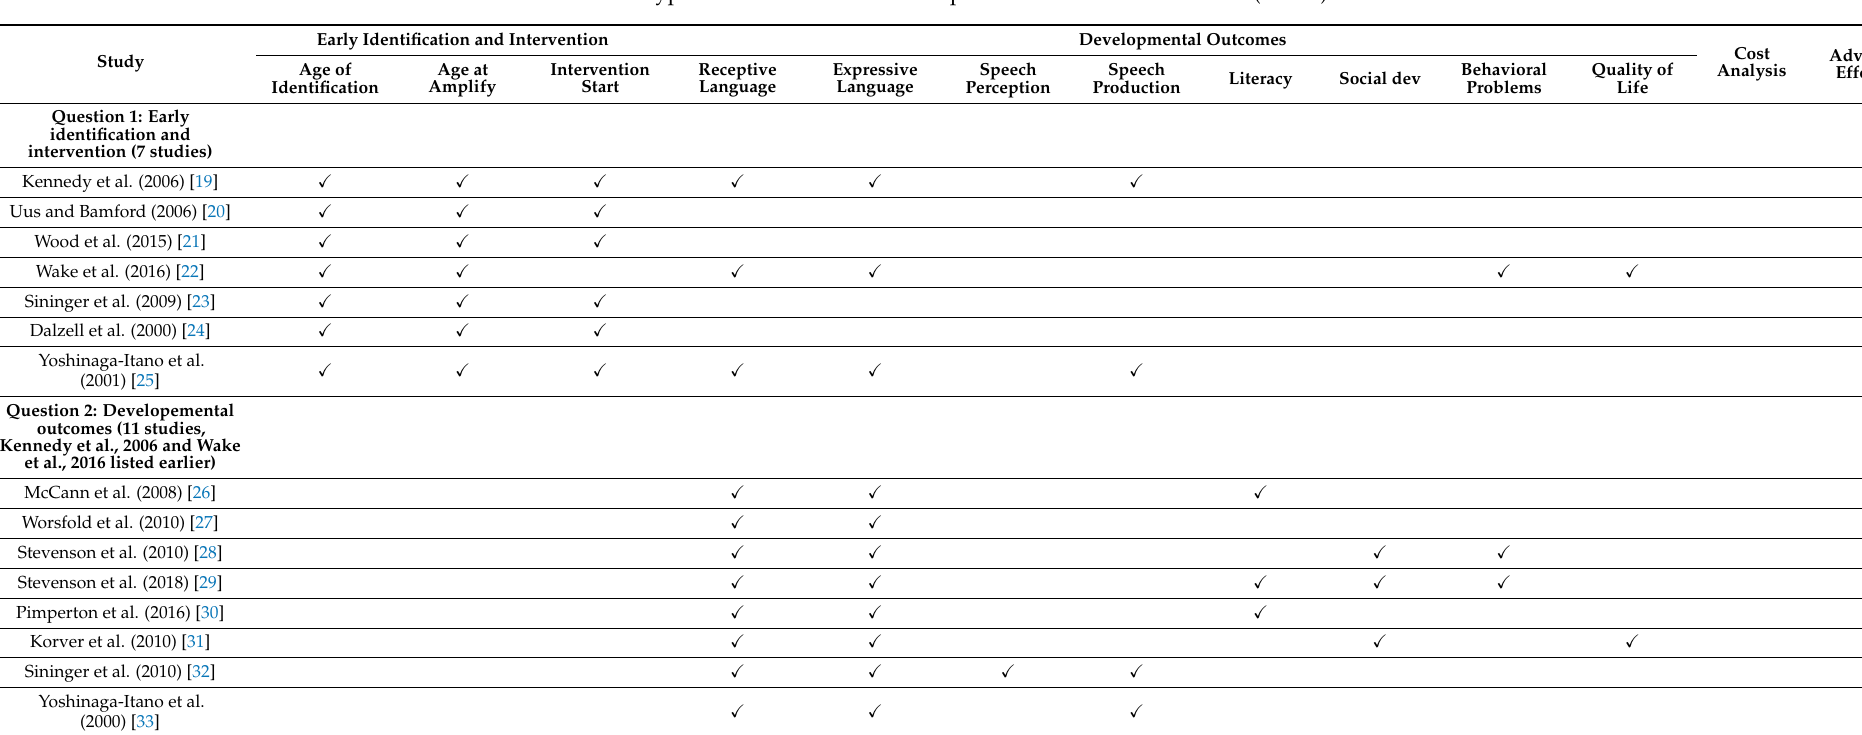
Table 3. Types of outcomes of UNHS reported in the studies included ( n =